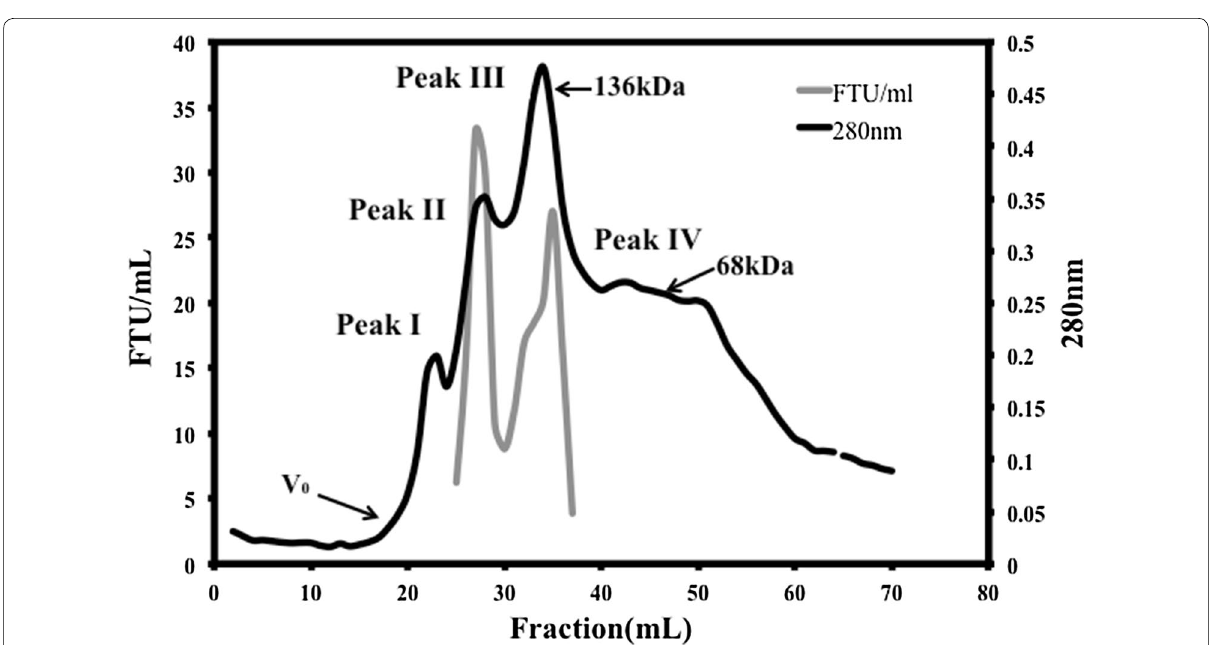
Fig. 1 Elution pattern of about 20 mg ammonium sulphate precipitated proteins from fungal spent culture in Sephacryl S-200HR column (95 cm 1.6 cm) and flow rate of 1 mL per min. The column was equilibrated and eluted in 0.1 M sodium acetate buffer, pH 5.0. All the tubes were × monitored for 280 nm absorbance for protein and enzyme activity. Standard protein (BSA) dimer (~ 136 kDa) and monomer (~ 68 kDa) was used to understand the approximate MW range where the phytase active protein eluted